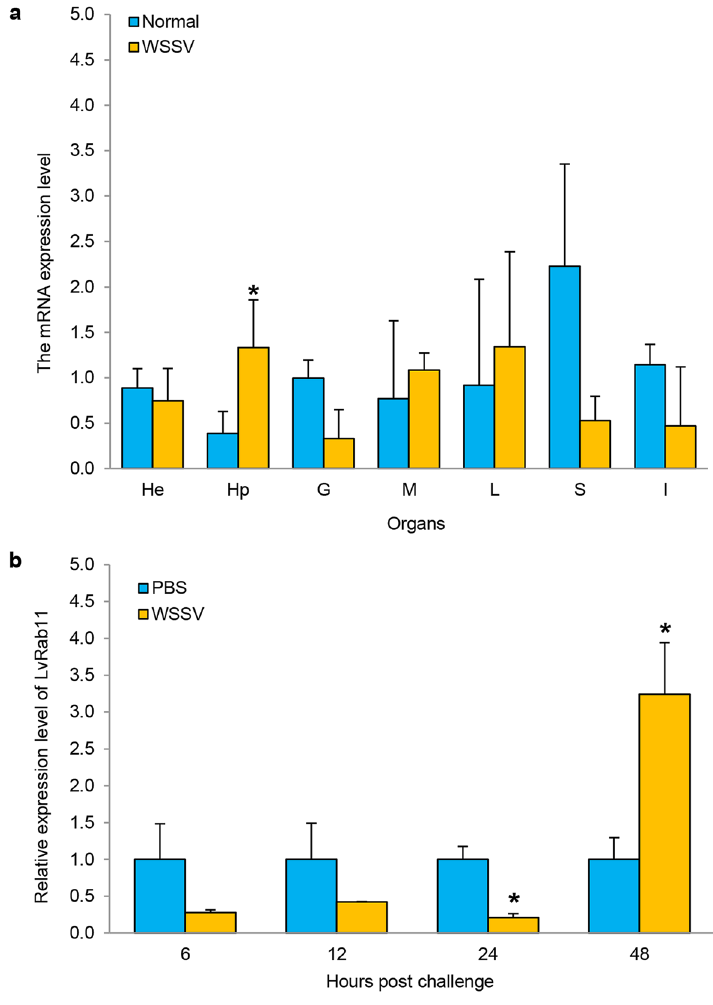
Figure 5. Expression profile of the LvRab11 transcripts in L. vannamei. ( a ) Gene expression of LvRab11 in various tissues of shrimp challenged with WSSV at 48 h post injection. The tissues examined included hemocytes (He), hepatopancreas (Hp), gill (G), muscle (M), lymphoid (L), stomach (S) and intestine (I), n = 3/ tissue. ( b ) The expression profiles of LvRab11 were analysed in the hepatopancreas of WSSV-challenged shrimp at various time points during infection, n = 3/time point. Error bars indicate standard deviations. Asterisks indicate significant differences ( p < 0.05) compared with the values of the